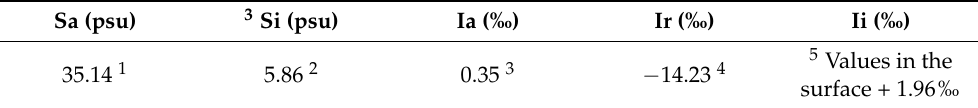
Table 3. End-member values used in mass balance